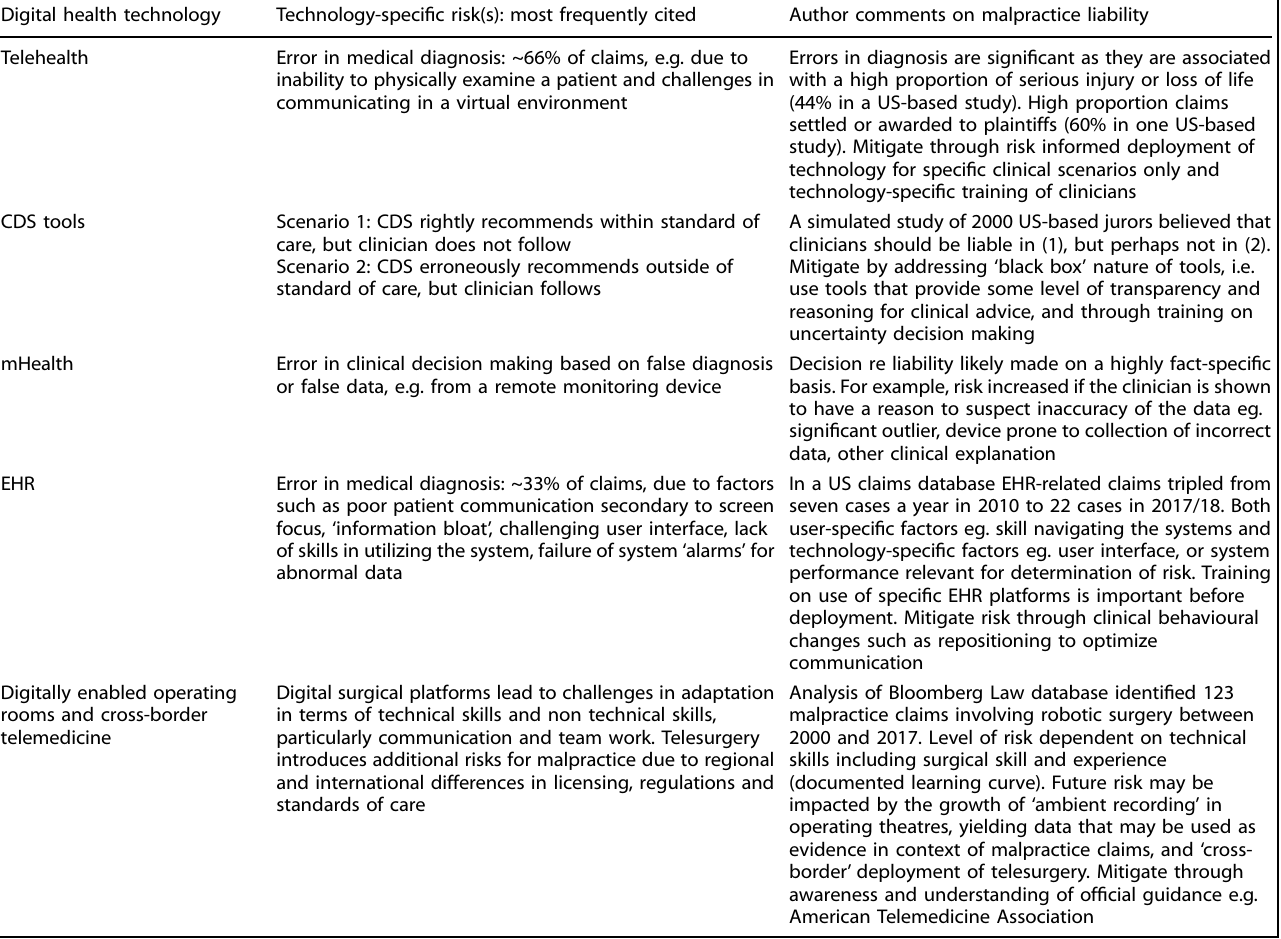
Table 1. Summary of most frequently cited technology-speci fi c risks for medical malpractice claims. Digital health